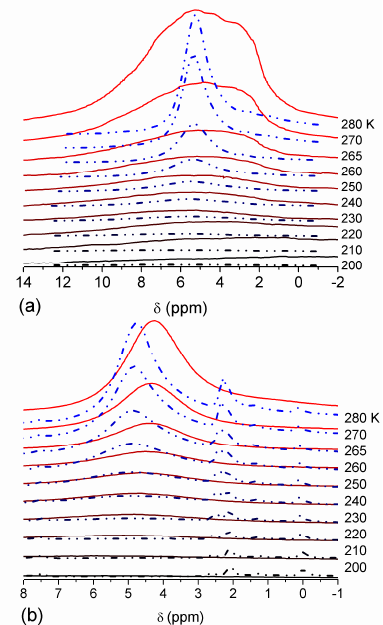
Figure 5. 1 H NMR spectra, recorded at different temperatures, of water bound in gelatin gel at hydration h = 1 g per gram of dried gelatin in different media: ( a ) air (solid lines) and C 6 D 6 :CD 3 CN = 6:1 (dashed-dotted lines), ( b ) C 6 D 6 (solid lines) and CDCl 3 :CD 3 CN = 3:1 (dashed-dotted lines) (reproduced from Ref. [47] with permission from The Royal Society of Chemistry).